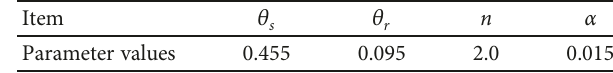
Figure 7: Calibration curve of the model. Table 2: Calibration of model